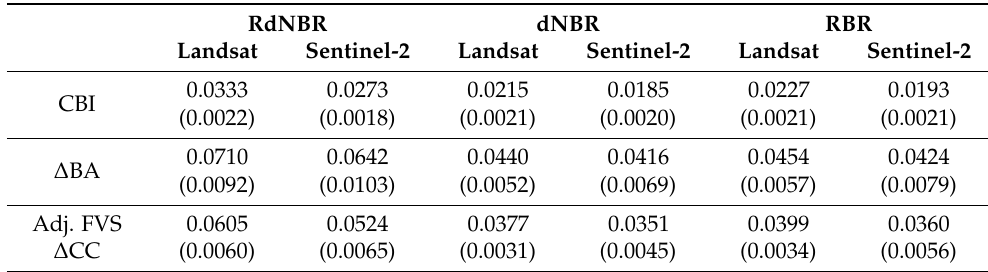
Table A7. Test MSE (and standard deviation of test MSE in parentheses) averaged across 7-fold CV of single-predictor GAM models for the IA time series.